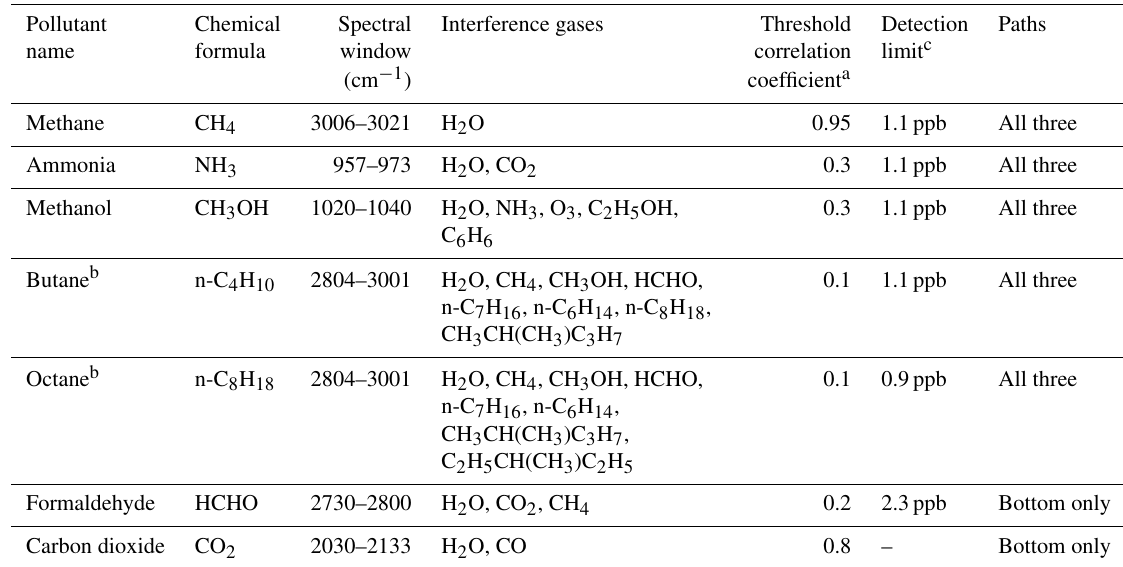
a Threshold correlation coefficient is a input for OPUS_RS when performing fitting analysis of FTIR spectra. When the correlation coefficient between measured spectrum and reference spectrum with the defined spectral window is below this threshold, that pollutant is not identified and the mole fraction